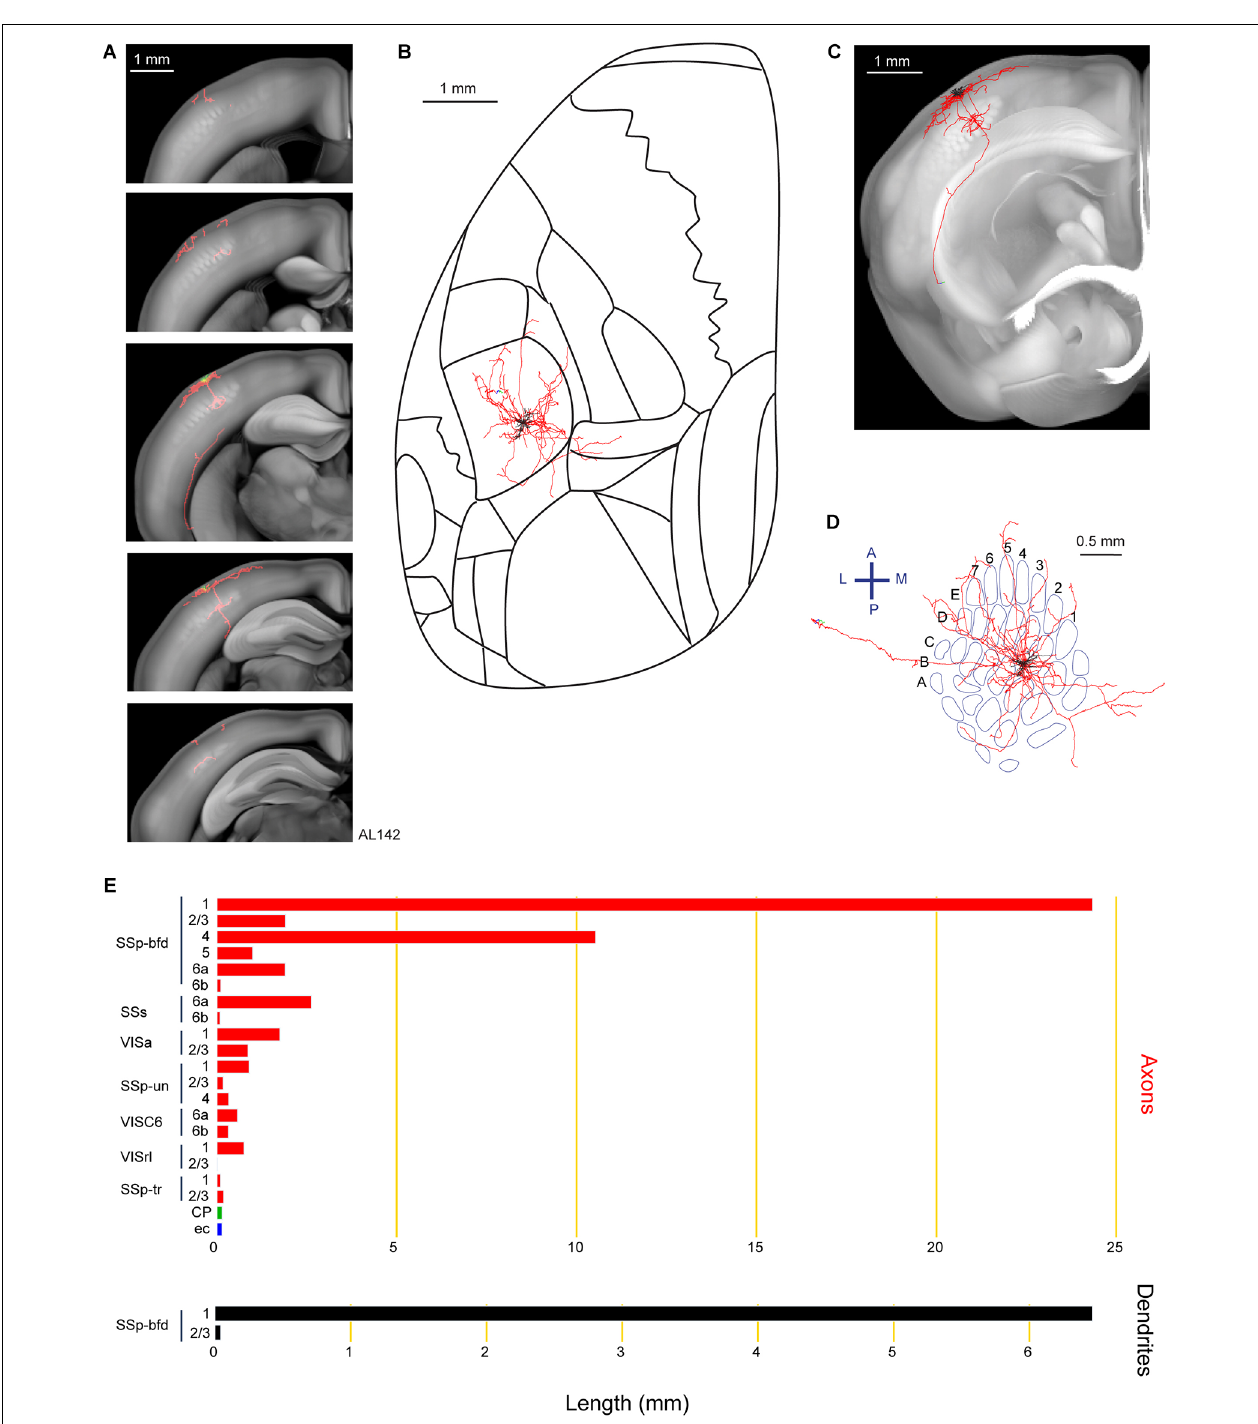
FIGURE 7 | Reconstruction and quantification of example neuron AL142 with projections to the lateral caudoputamen and towards the amygdala. (A) Serial overlays of axon (red) and dendrites (green) in coronal views encompassing the anterior-posterior span of the axons of 2.375 mm. Each section represents a maximum projection of 475 µ m. (B) Maximum projection of the reconstructed axon and dendrites in horizontal view. (C) Maximum projection of the axon and dendrites in coronal view. (D) Maximum projection of the axon and dendrites in tangential view (rotated 30 degrees) over the barrel field. The cell is in the septa between the D2 and D3 barrel columns. (E) Quantification of axonal (top) and dendritic (bottom) length in respective brain regions identified by the Allen Mouse CCFv3. For (B) to (E) : dendrites are shown in black; axon in neocortical gray matter is shown in red; axon in the striatum is shown in green; axon in white matter is shown in